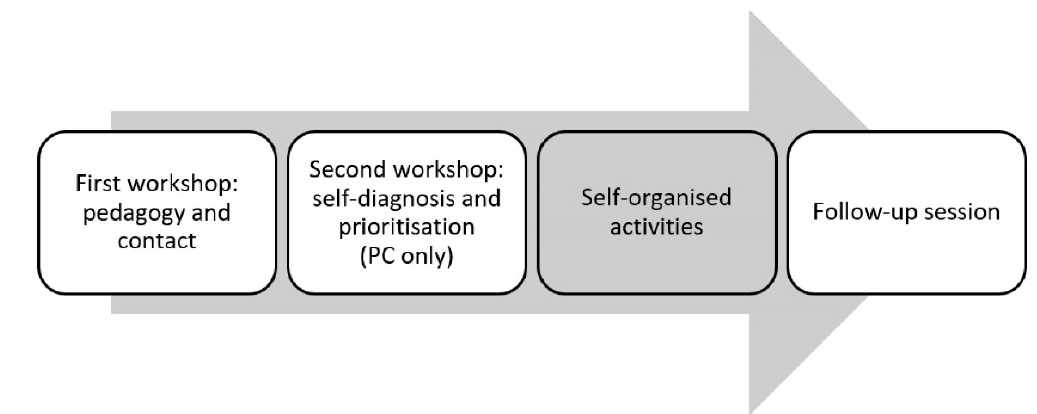
Figure 1. Flow diagram of the intervention structure. The sessions supported by the activists are coloured in white, the activity self-organised by the professionals is coloured in grey. PC: Primary Care.